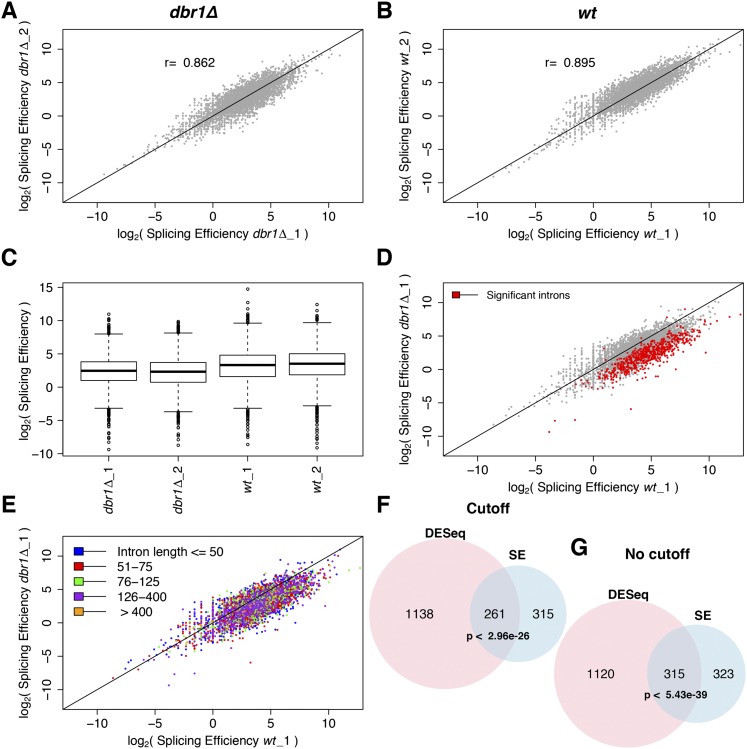
Splicing efficiency is decreased in dbr1Δ cells. (A,B) Correlation of splicing efficiency (SE) between biological replicates in dbr1Δ (A) and wild type (B). Each dot represents one of 5361 introns; (r) Pearson’s correlation coefficient. (C) Box plot showing SE in dbr1Δ and wild-type cells (P < 2.2 × 10−16, Wilcoxon rank sum test). (D) Comparison of SE between dbr1Δ and wild type. (Red) 638 introns showing significant changes in SE (CMH test; Q < 0.05). (E) As in D but with introns binned according to their size as indicated in color legend. (F,G) Overlap between introns with lower SE and introns with higher expression (DESeq), both with and without fold-change cutoff. The indicated P-values for overlaps are based on a hypergeometric test.